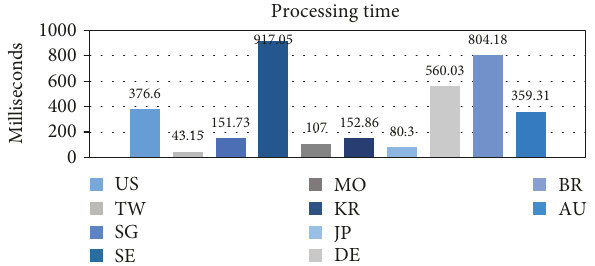
Figure 14: Geographical measurements of the emulation mode with time (processing